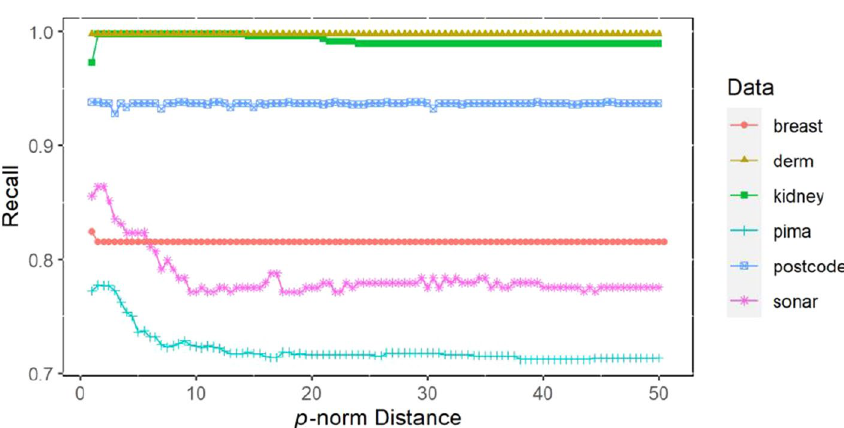
Figure 3. The fivefold cross-validation recall varies with p -norm distance based on 6 datasets.